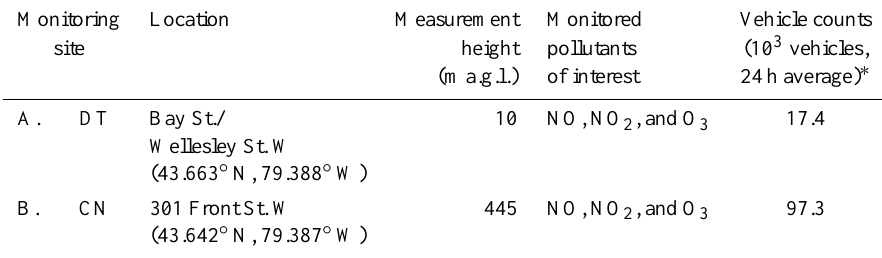
Table 1. Location of in situ monitoring sites and pollutants of